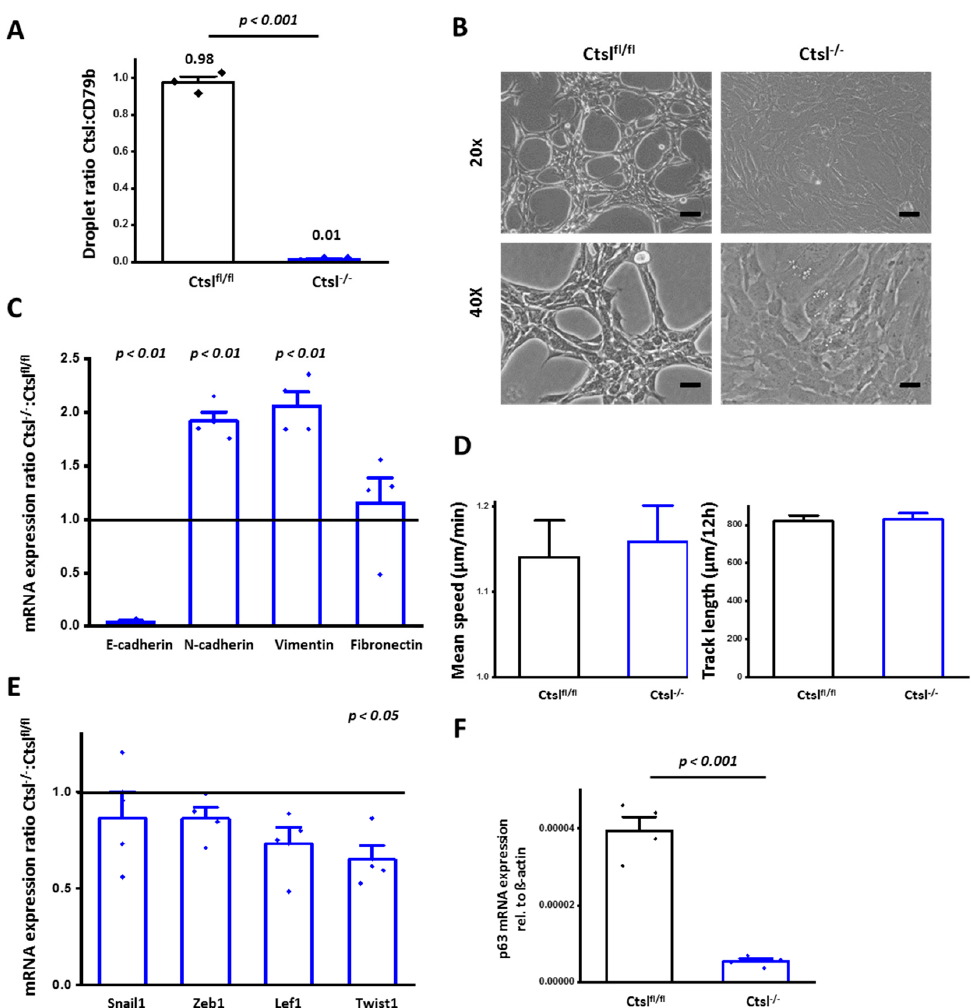
Figure 4. Generation and characterization of Ctsl − / − cells by in vitro recombination of Ctsl fl / fl cells. ( A ) Confirmation of Ctsl DNA in three independent batches of Ctsl fl / fl control cells and in vitro recombined Ctsl − / − cells by droplet digital PCR quantification. The recipient cells used for in-vitro recombination were a Ctsl floxed mammary epithelial cell line, isolated from an end-stage tumor originating in a female Ctsl fl / fl (control) mouse. CD79b was used as a reference gene, in order to quantify the Ctsl-positive droplets. ( p < 0.001, Two-tailed t -test) ( n = 4) mean ± S.E.M. ( B ) Bright field microscopy pictures of Ctsl fl / fl and inducible Cre-transduced mammary epithelial Ctsl − / − cancer cells in 3-day cultures di ff er considerably in their morphology and proliferative potential. Cell clusters are observable in Ctsl fl / fl . Epithelial Ctsl − / − cancer cells display white dots representing enlarged vesicles (Scale bar: 20 × : 50 µ m, 40 × : 100 µ m). ( C ) Quantification of mRNA expression of EMT markers. Significant di ff erences were found in E-cadherin ( p < 0.01, one-way ANOVA, Tukey post-hoc test), N-cadherin ( p < 0.001, one-way ANOVA, Tukey post-hoc test), vimentin ( p < 0.01, one-way ANOVA, Tukey post-hoc test), supporting a phenotype other than epithelial ( n = 4) mean ± S.E.M. ( D ) Cell tracking assay, monitoring cell movement, mean velocity and path length of cells plated at low density were tracked over 12 hours. Mean velocity and mean track measured by cell tracking showed no di ff erence in the speed and the distance the cells covered during the experiment ( n = 45); mean ± S.E.M. ( E ) Quantification of mRNA expression of EMT transcription factors Snail1, Zeb1, Lef1, and Twist1. A significant decrease in the transcription levels of Twist1 was found in Ctsl − / − cells. ( p < 0.05, one-way ANOVA, Tukey